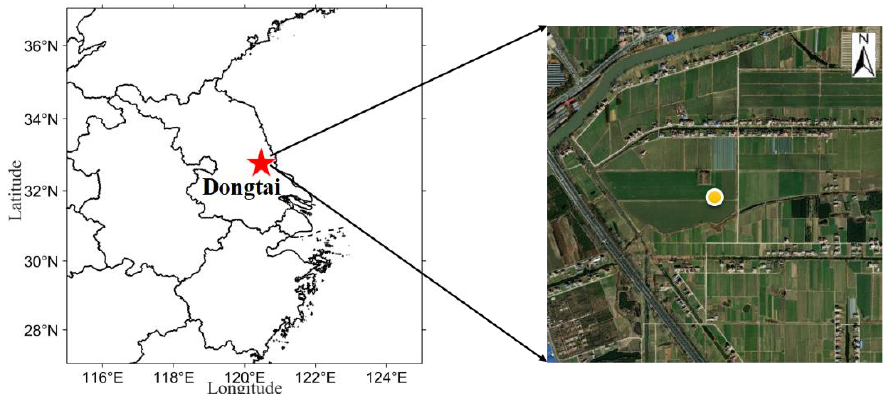
Figure 1. Map showing the location of Dongtai station (red star) and a satellite image showing the location of the study site (yellow point).